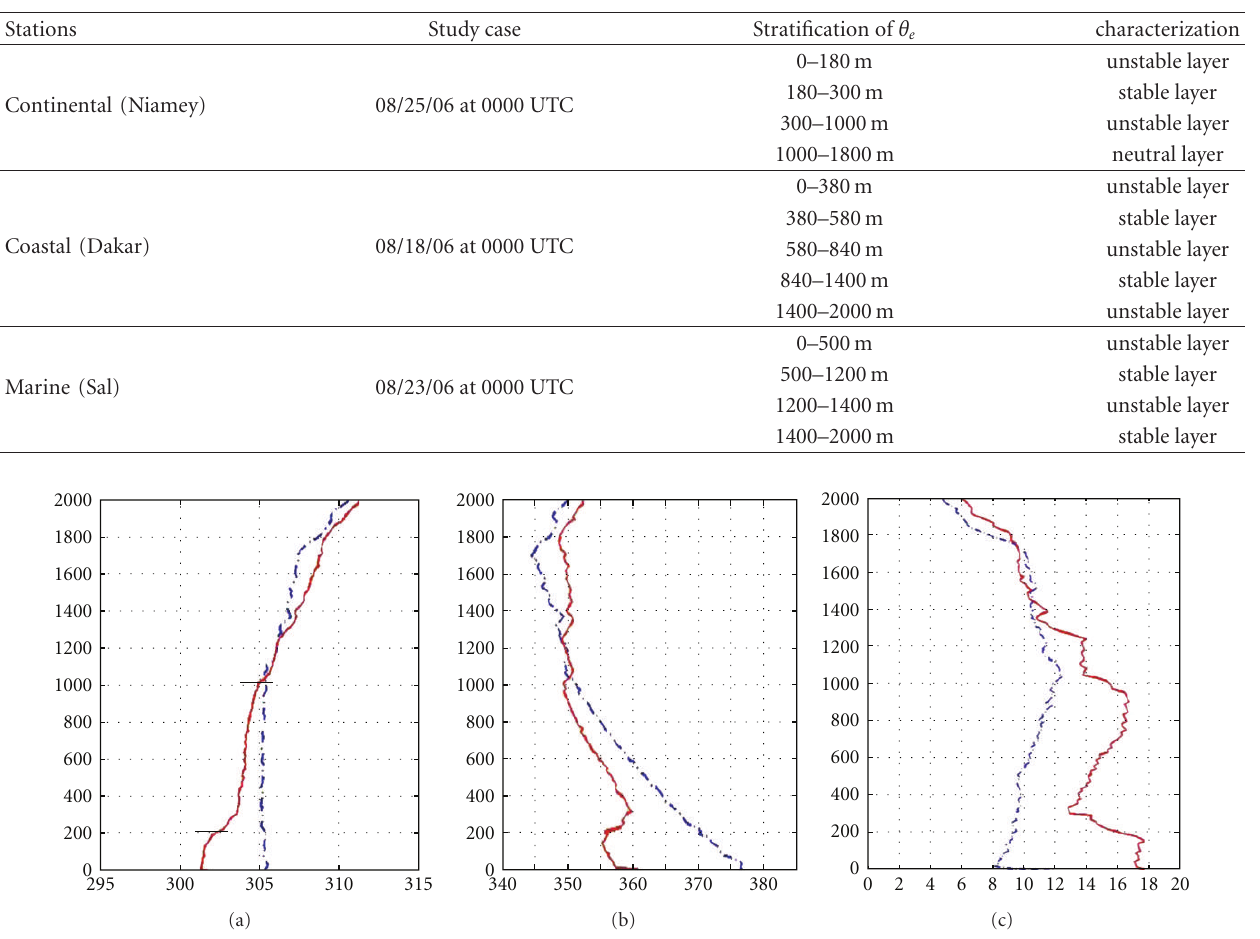
Figure 12: Potential temperature θ (a), equivalent potential temperature θ e (b), and mixing ratio r (c) profiles 08/26/06 at 0000 UTC (red) and 1200 UTC (blue) in